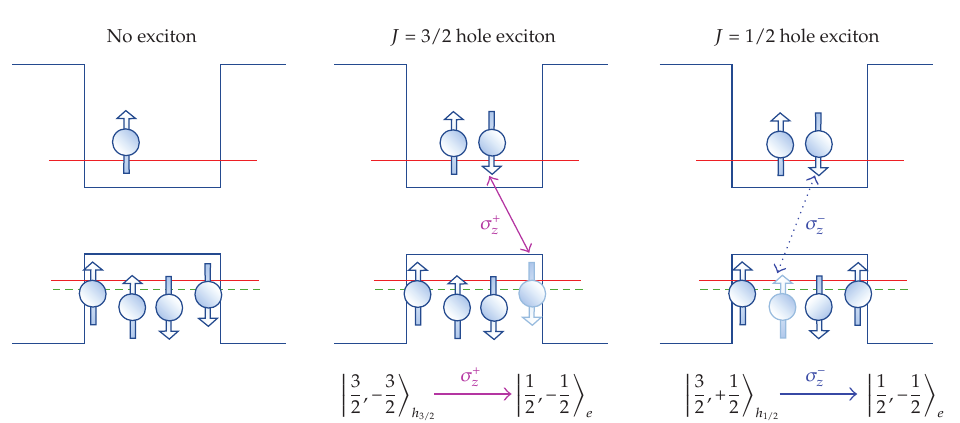
Figure 3: Dipole selection rules in the quantum network